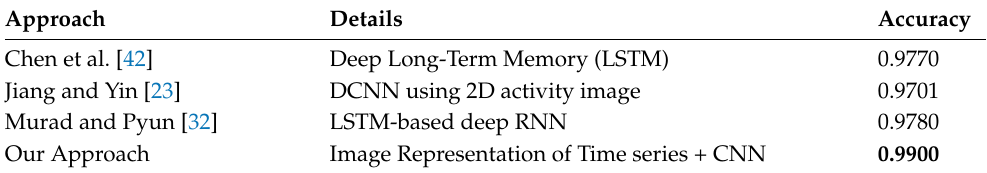
Table 4. Comparison considering USC-HAD dataset.